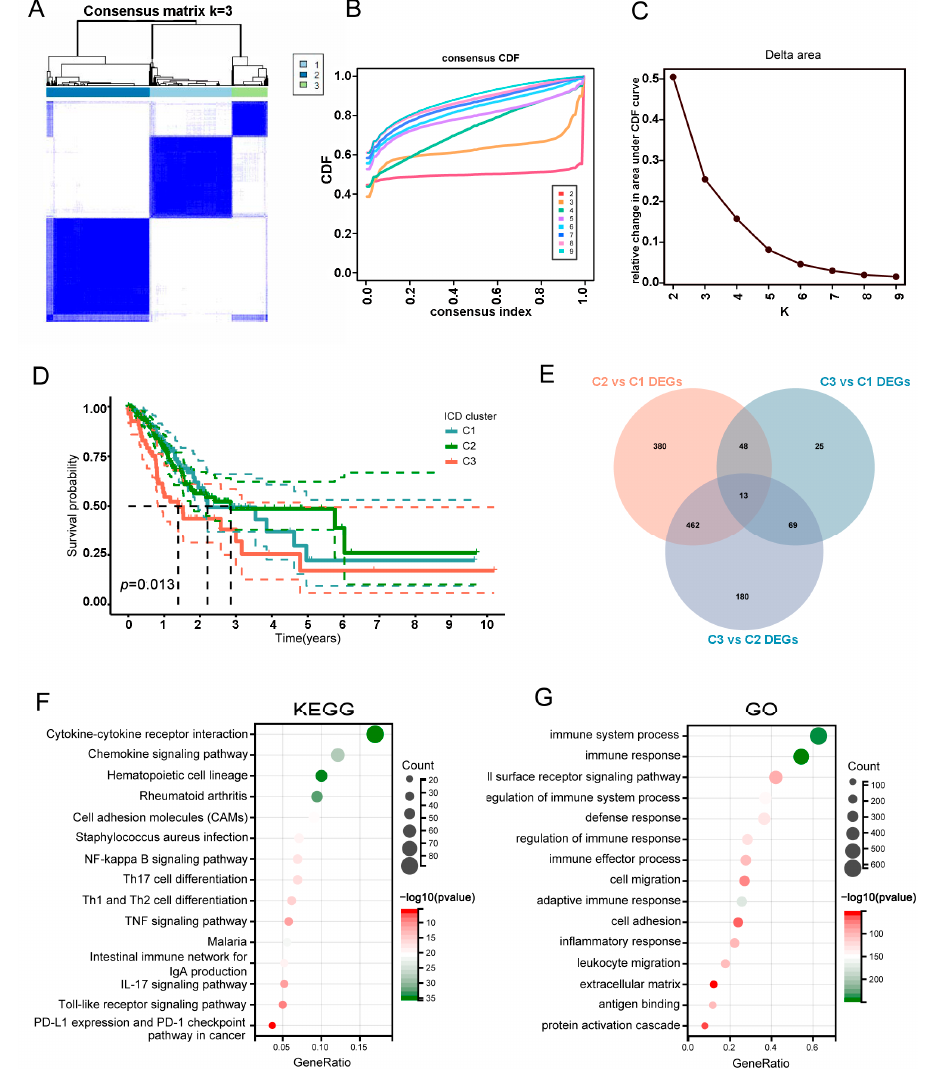
Figure 2. Identification of ICD-related subgroups by consensus clustering. ( A – C ) Consensus matrix heatmap defining 3 clusters (k = 3). ( D ) Kaplan–Meier curves of OS in distinct subtypes. ( E ) Venn diagram showing 1177 DEGs between the three ICD-related subtypes. ( F , G ) KEGG and GO enrichment analyses of DEGs among three ICD-related subtypes. DEGs, differentially expressed genes; KEGG, Kyoto Encyclopedia of Genes and Genomes; GO, gene